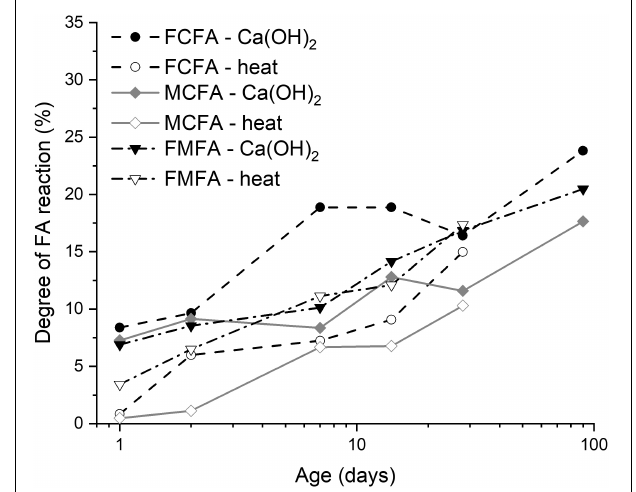
FIGURE 11 | Estimated degree of reaction of the fly ashes (FCFA, fine classified fly ash; MCFA, medium classified fly ash; FMFA, fine milled fly ash) derived from portlandite consumption [Ca(OH) 2 ] and heat release (heat).